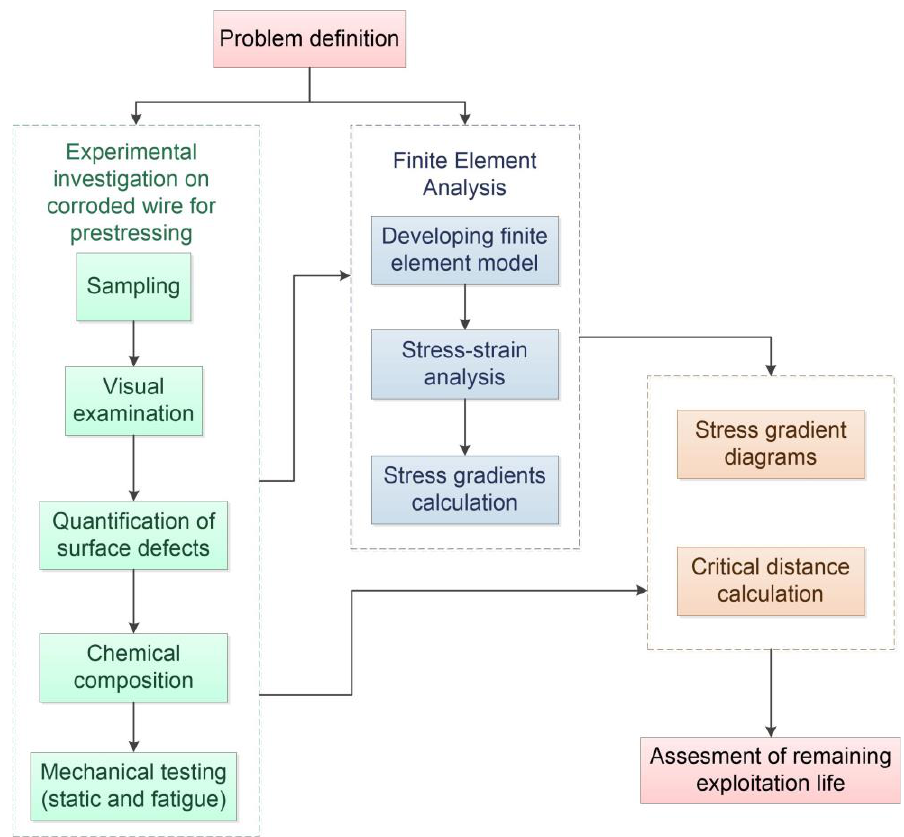
Figure 1. Methodology for life assessment of corroded wire for prestressing.